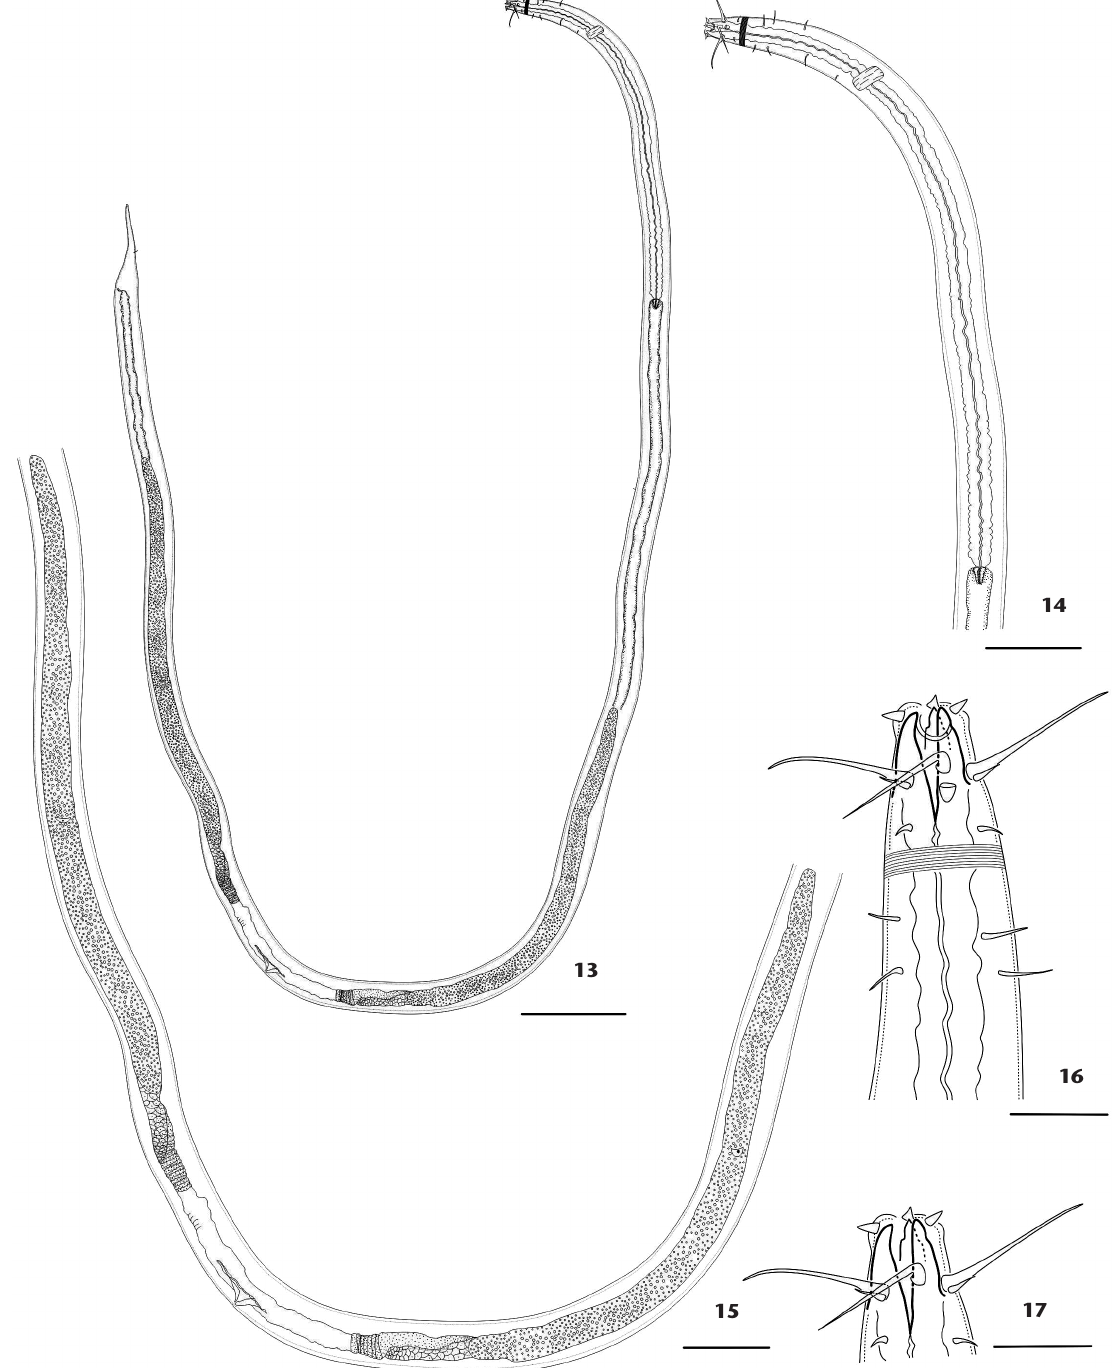
Figures 13-17. Allotype of Trileptium ribeirensis sp. nov. : (13) total body; (14) anterior region with pharynx, nerve ring, somatic seta and cardia; (15) body region showing the vulva and ovaries; (16-17) anterior region emphasizing the cephalic ring and amphid: (16), teeth and jaws (17). Scale bars: 13 = 200 µm, 14, 15 = 100 µm, 16, 17 = 50